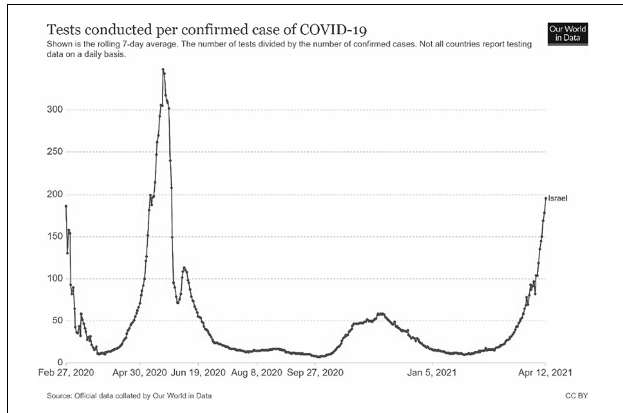
FIGURE 1 | Test conducted per confirmed cases of COVID-19 in Israel.